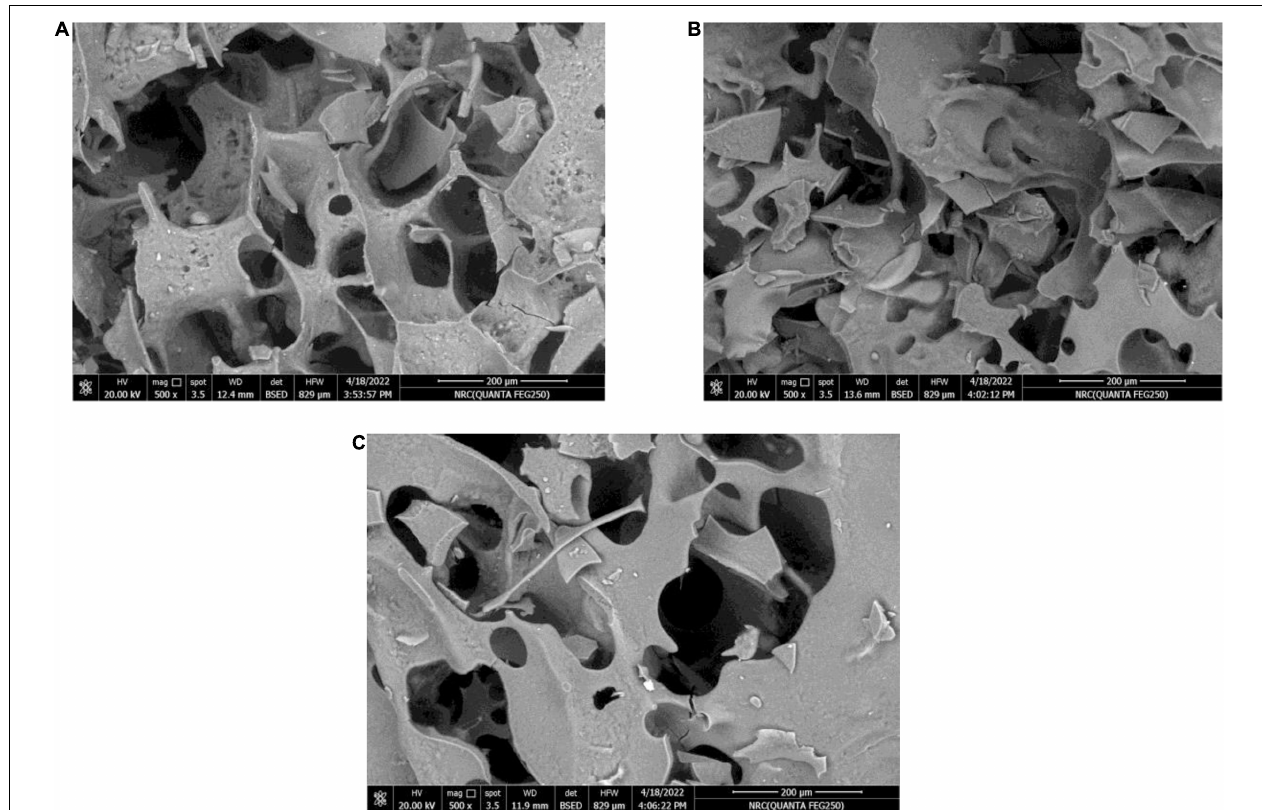
FIGURE 3 | Scanning electron microscope (SEM) images of the red beet (RB) (A) , broccoli (BR) (B) , and spinach leaf (SL) (C) complex coacervate microcapsules (after